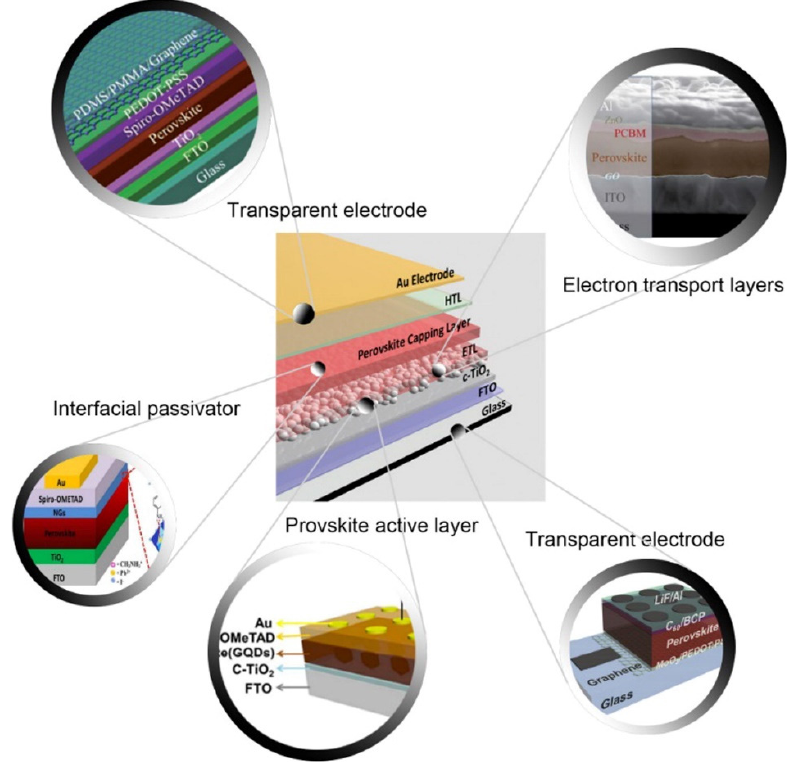
Figure 8. Schematic illustration of graphene and its derivatives in polymer solar cells (reproduced from [245] with permission from Elsevier).